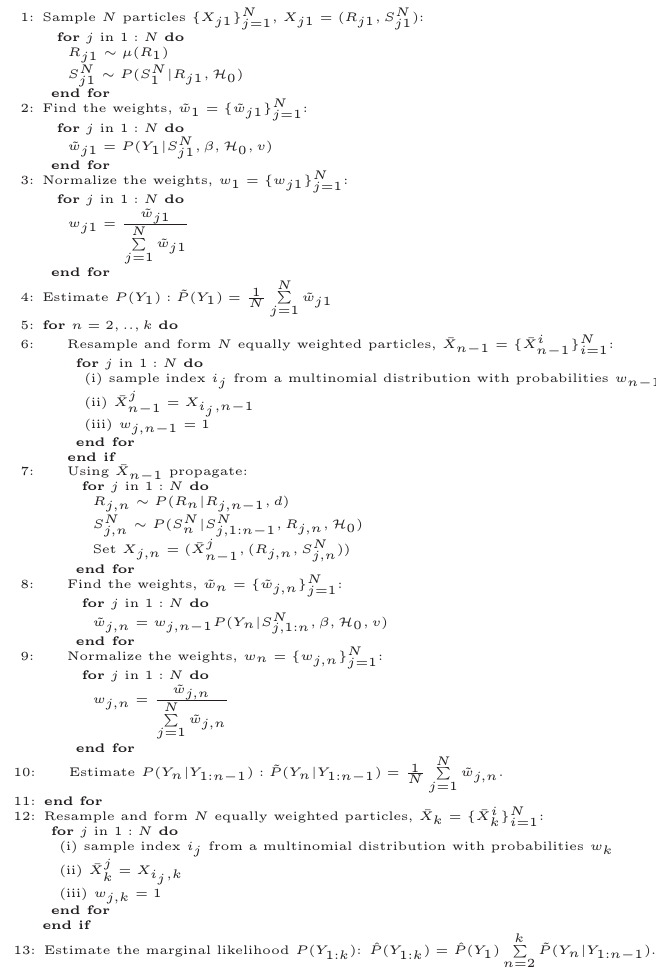
Algorithm 4 Bootstrap